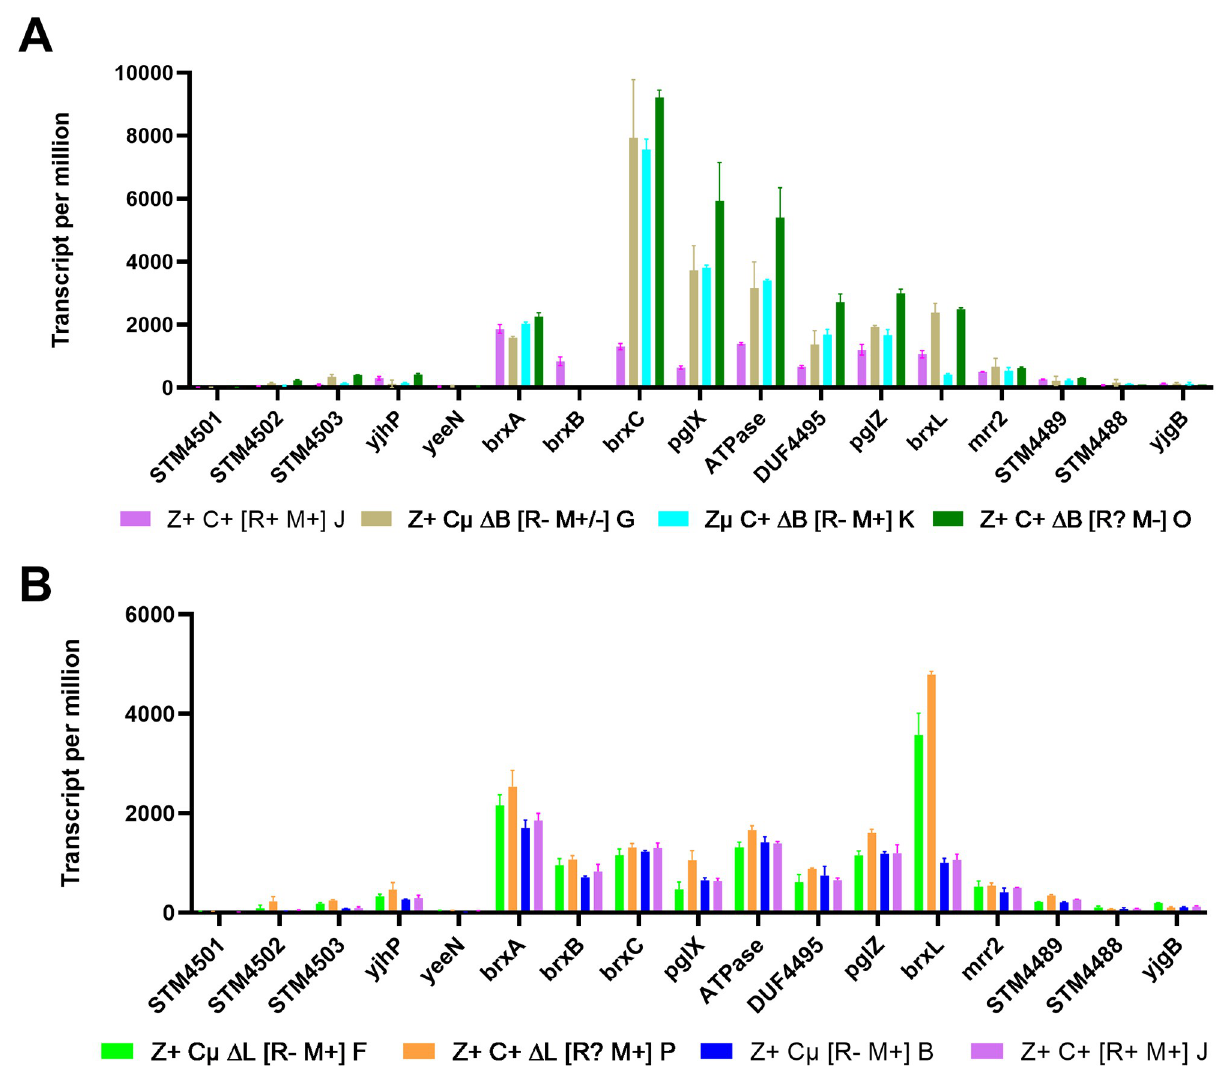
Fig 5. Δ brxC::cat and Δ brxL::cat each have a large effect on transcription of the StySA locus. The X axis displays CDS names in the StySA/BREX locus and its flanks. Ordinate is transcripts mapping to each CDS per million. Panel A: StySA/BREX WT and three combinations of Δ B :: cat with brxC and brxZ alleles (Z+C+ [R+M+] strain J; Z+C μ [R-M+/-] strain G; Z μ C+ Δ B [R-M+] strain K; Z+C+ [R?M-] strain O). Panel B: two Δ L :: cat strains (F, P) paired with L + ancestors (B, J). About 700 nt of the 3’ end of brxL is present in Δ brxL :: cat .